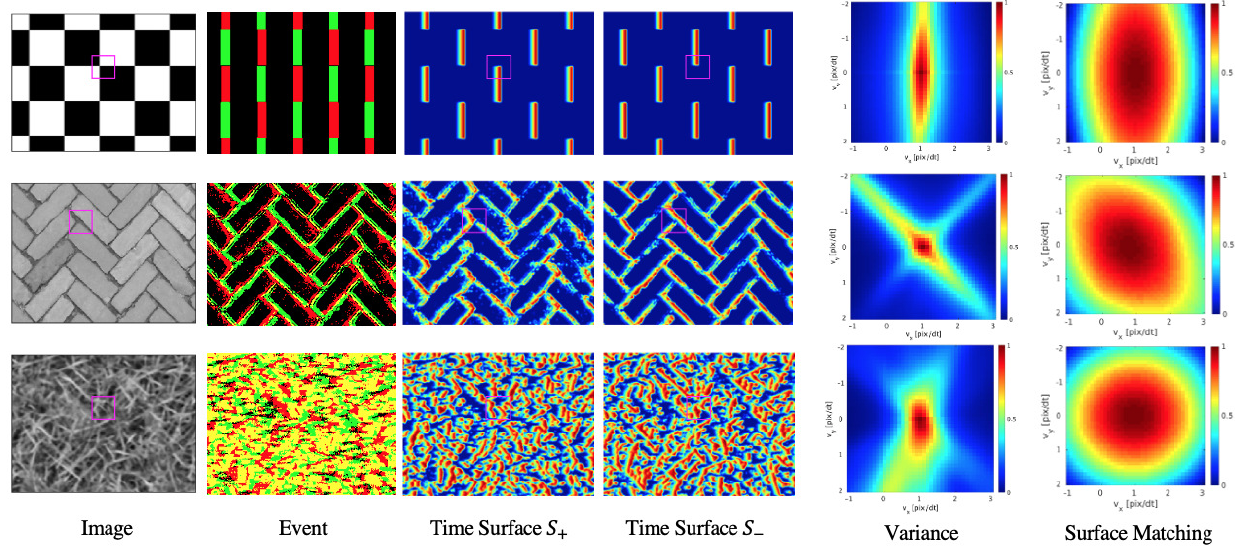
Figure 6. Visualization of loss landscape of Variance and Surface Matching Loss in the scene of checkerboard, brick and grass under the condition that the true optical flow is set to v = ( 1,0 ) (cid:62) (pix/ ∆ t ). The loss functions are evaluated in a magenta